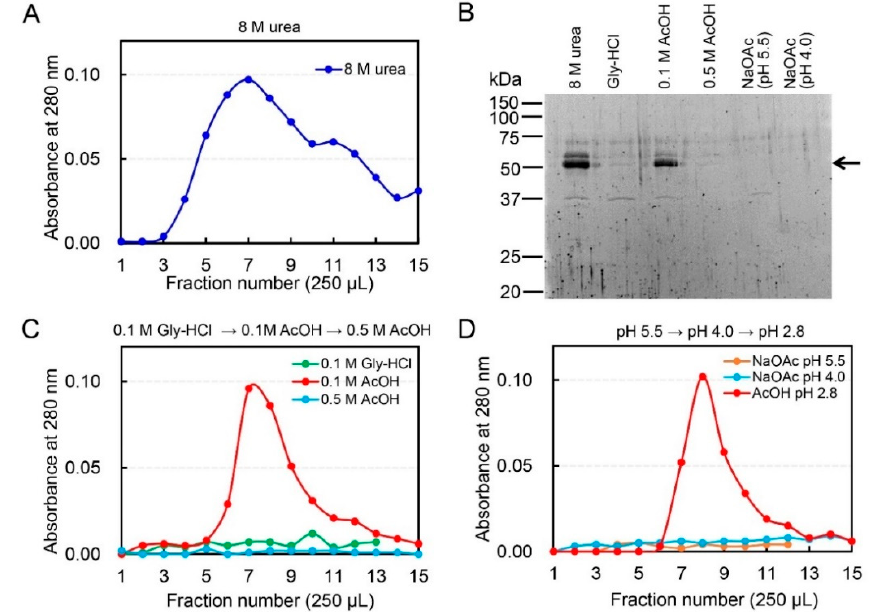
Figure 1. Specific dissociation of chicken acidic chitinase (Chia)-chitin by 0.1 M acetic acid. ( A ) Elution profiles of chicken Chia from chitin column by 8 M urea. The soluble fraction of chicken glandular stomach was applied onto the column. Bound chitinase was eluted from the column with 8 M urea. ( B ) SDS-PAGE analysis of the protein fractions. Arrow highlights the positions of the Chia protein. ( C ) Elution profiles of Chia from chitin column by 0.1 M Gly-HCl (pH 2.5) or 0.1 M acetic acid (pH 2.8). The column was further washed with 0.5 M acetic acid. ( D ) Elution of bound Chia by 0.1 M sodium acetate (pH 4.0 or pH 5.5). Bound Chia was finally eluted from chitin column by 0.1 M acetic acid.